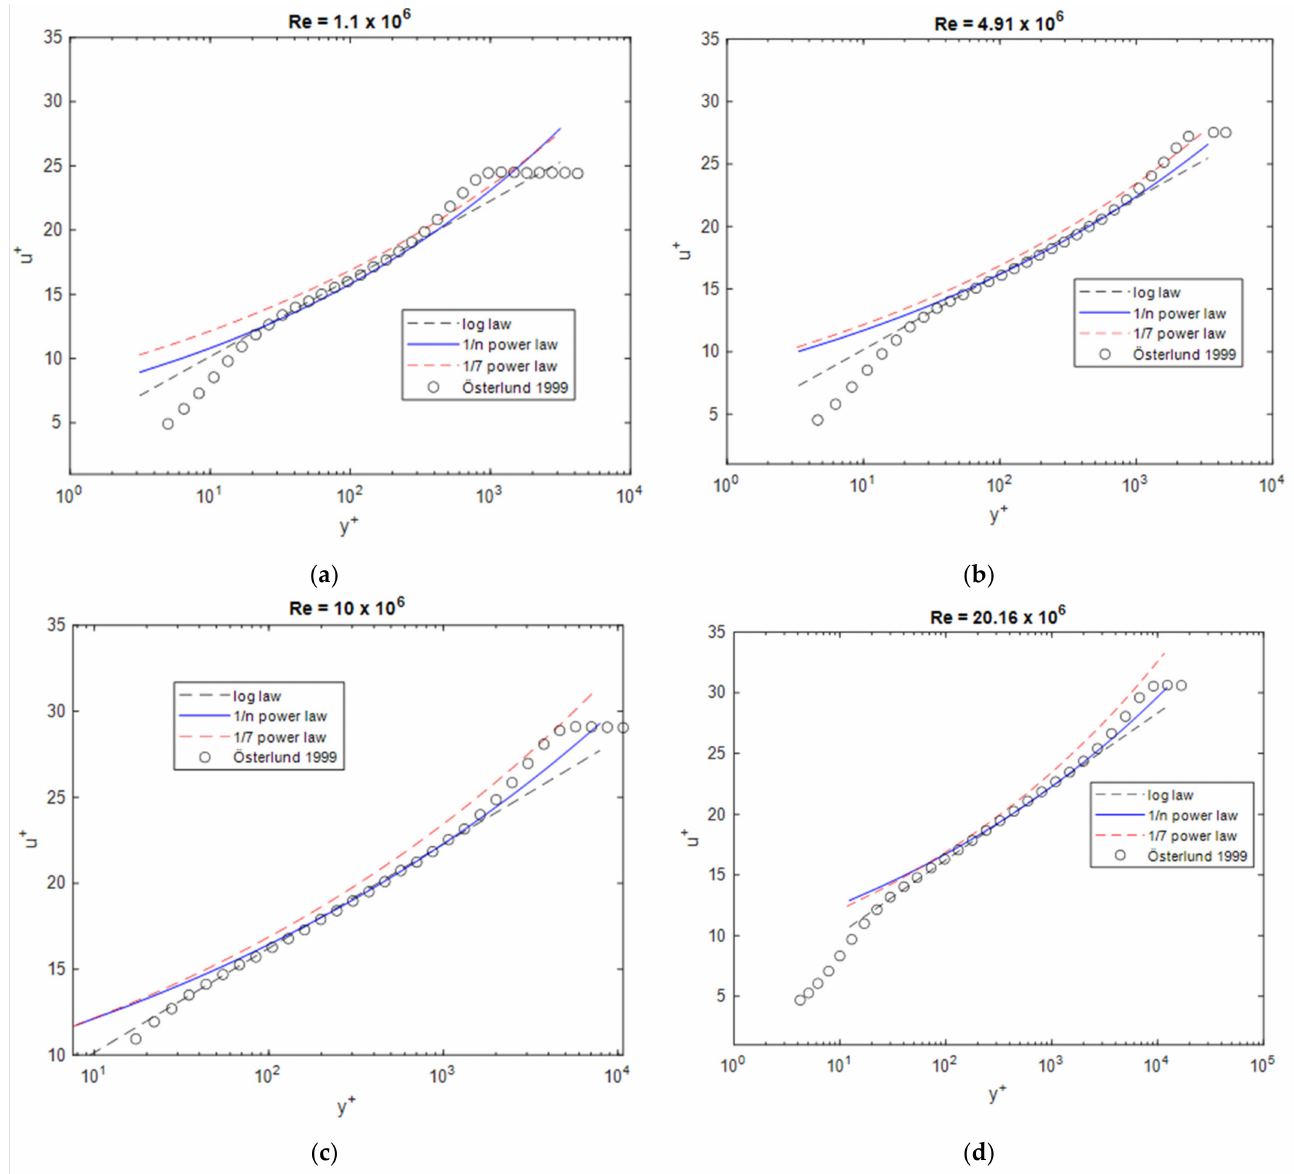
Figure 6. Boundary layer profiles at different Reynolds numbers Re x compared to the data from Österlund [10], ( a ) Re = 1.1 × 10 6 , ( b ) Re = 4.91 × 10 6 , ( c ) Re = 10 × 10 6 , ( d ) Re = 20.16 × 10 6